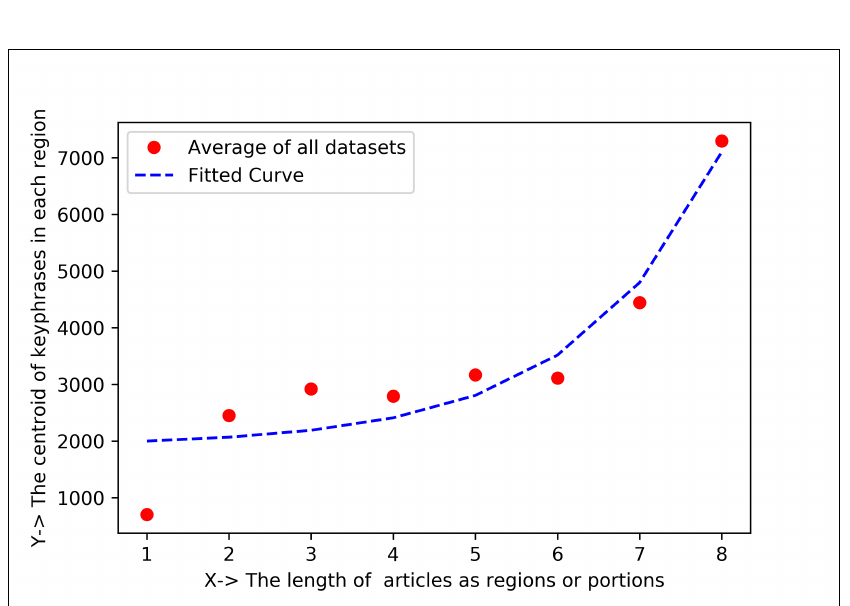
Figure 11. The analysis of curve fitting technique for AC value of all datasets based on 8-regions.